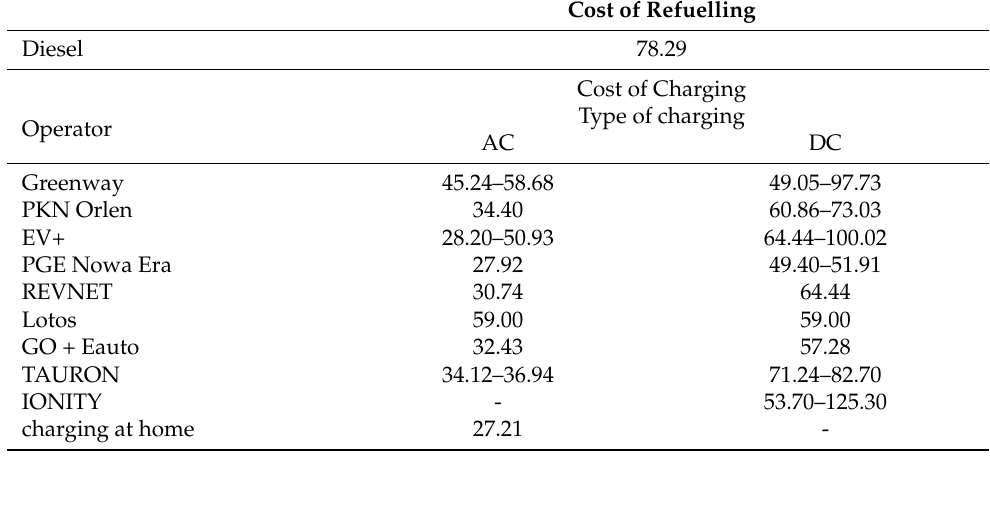
Table 2. Cost of a 100 km journey in the analysed vehicles [PLN].